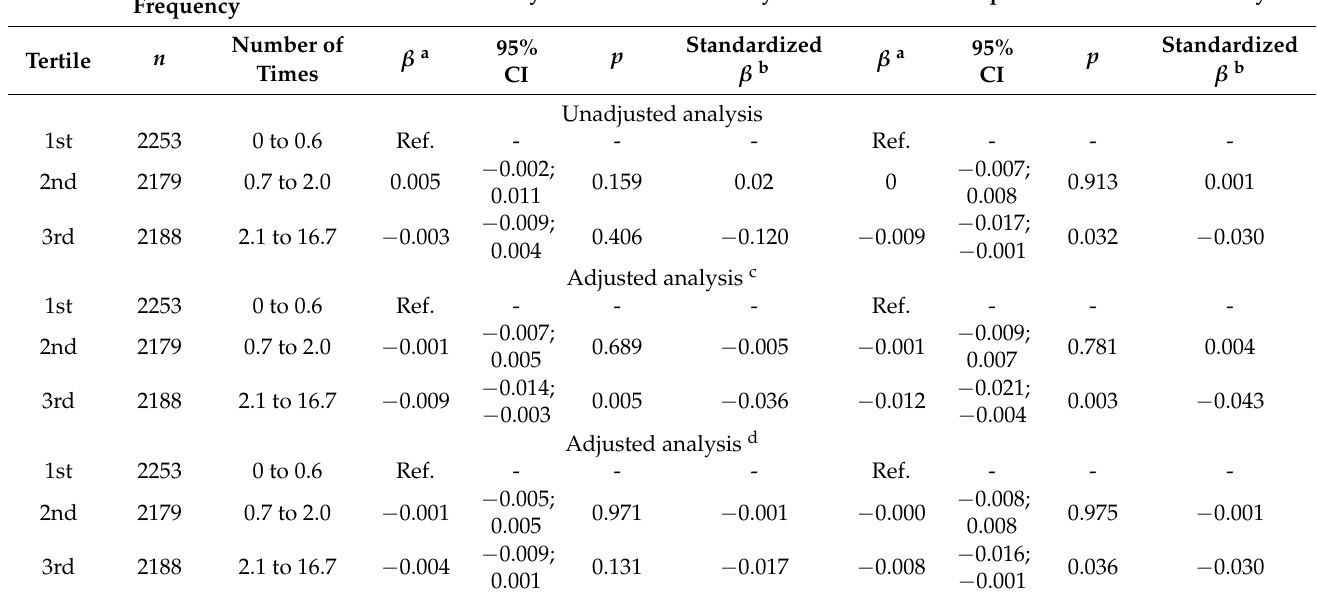
Table 3. Association between the daily consumption frequency of sugar-sweetened beverages and bone mineral density in young people of the RPS Brazilian Birth Cohorts Consortium (Ribeir ã o Preto, Pelotas, and S ã o Lu í s). Ribeir ã o Preto 2016/2017, Pelotas 2015/2016, and S ã o Lu í s